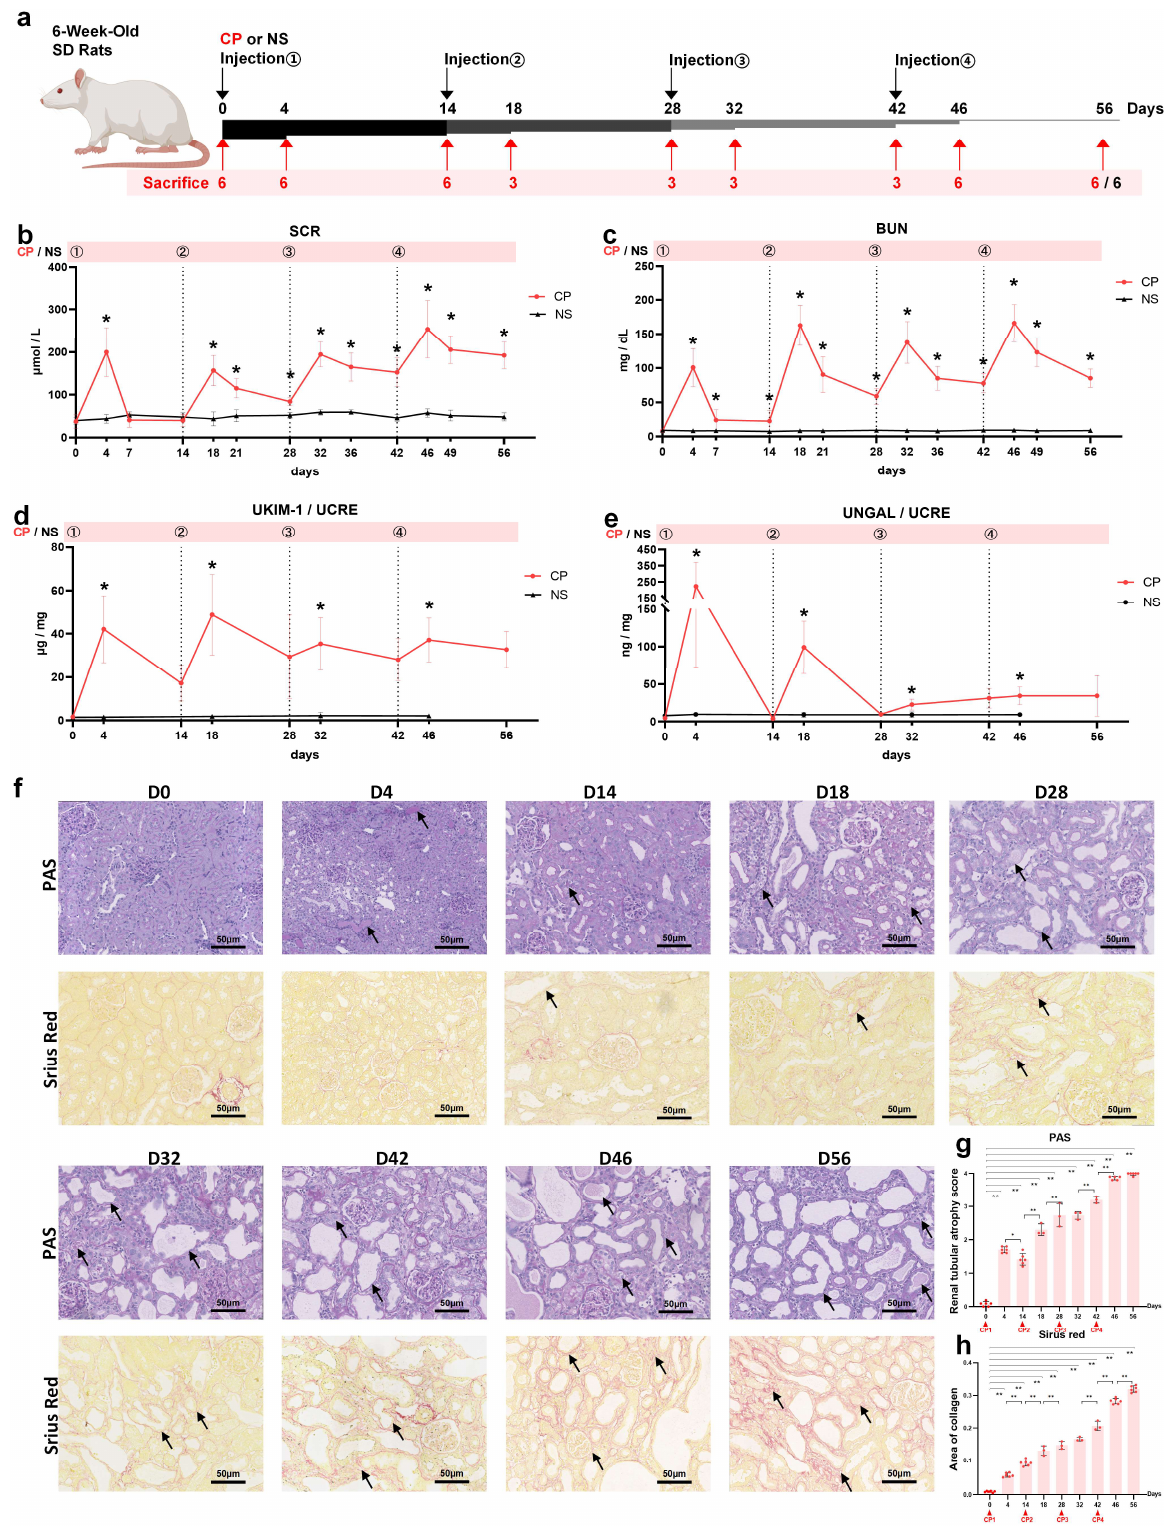
Figure 1. The four-time intraperitoneal injection of low-dose cisplatin (CP) induced AKI-to-CKD transition in rats. ( a ) Study design overview. Rats (6 weeks old) were injected with 3.2mg/kg cisplatin every 14 days as the CP group and 6 of them were randomly sacrificed at days 0, 4, 14, 46 and 56; and 3 at days 18, 28, 32 and 42. The normal control (NC) group was injected with the same volume of sterile 0.9% NaCl and was maintained for 56 days. Changes in ( b ) SCR, ( c ) BUN, ( d )